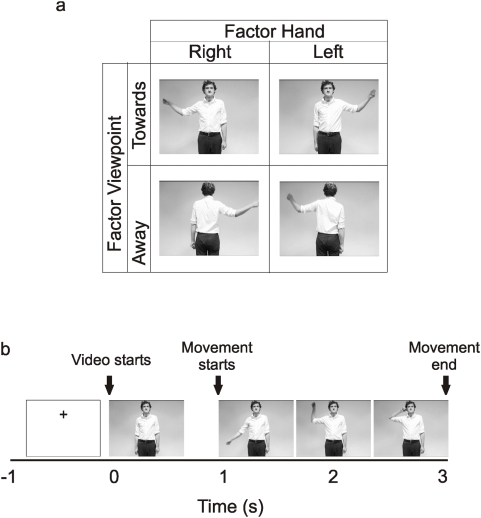
Experimental design.Figure 4a stills from the videos of experiment 2 showing the 2×2 factorial design collapsed across the factors goal. The factors depicted here are hand moved and the viewpoint. Figure 4b shows the time course of a typical trial.